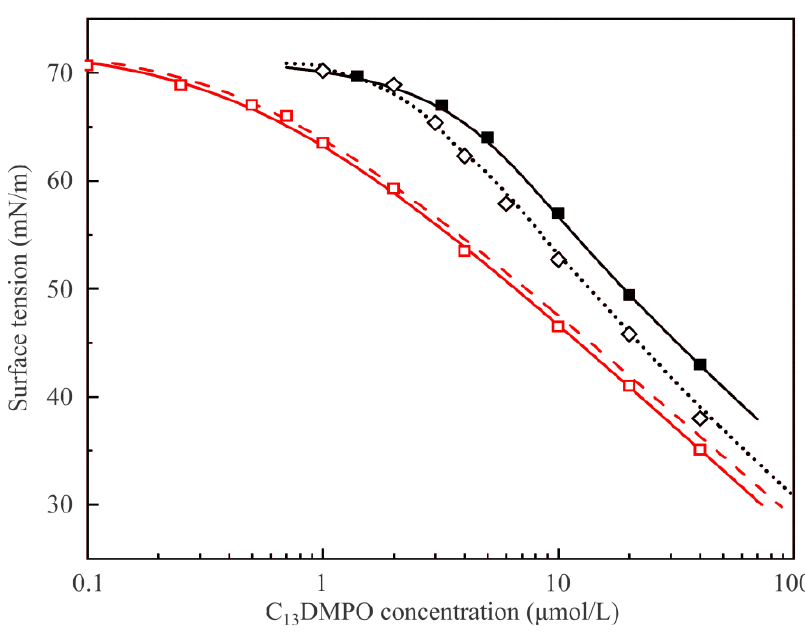
Figure 5. Equilibrium surface tension isotherms for the aqueous C 13 DMPO solution/air interface obtained by various methods. For details, see text.